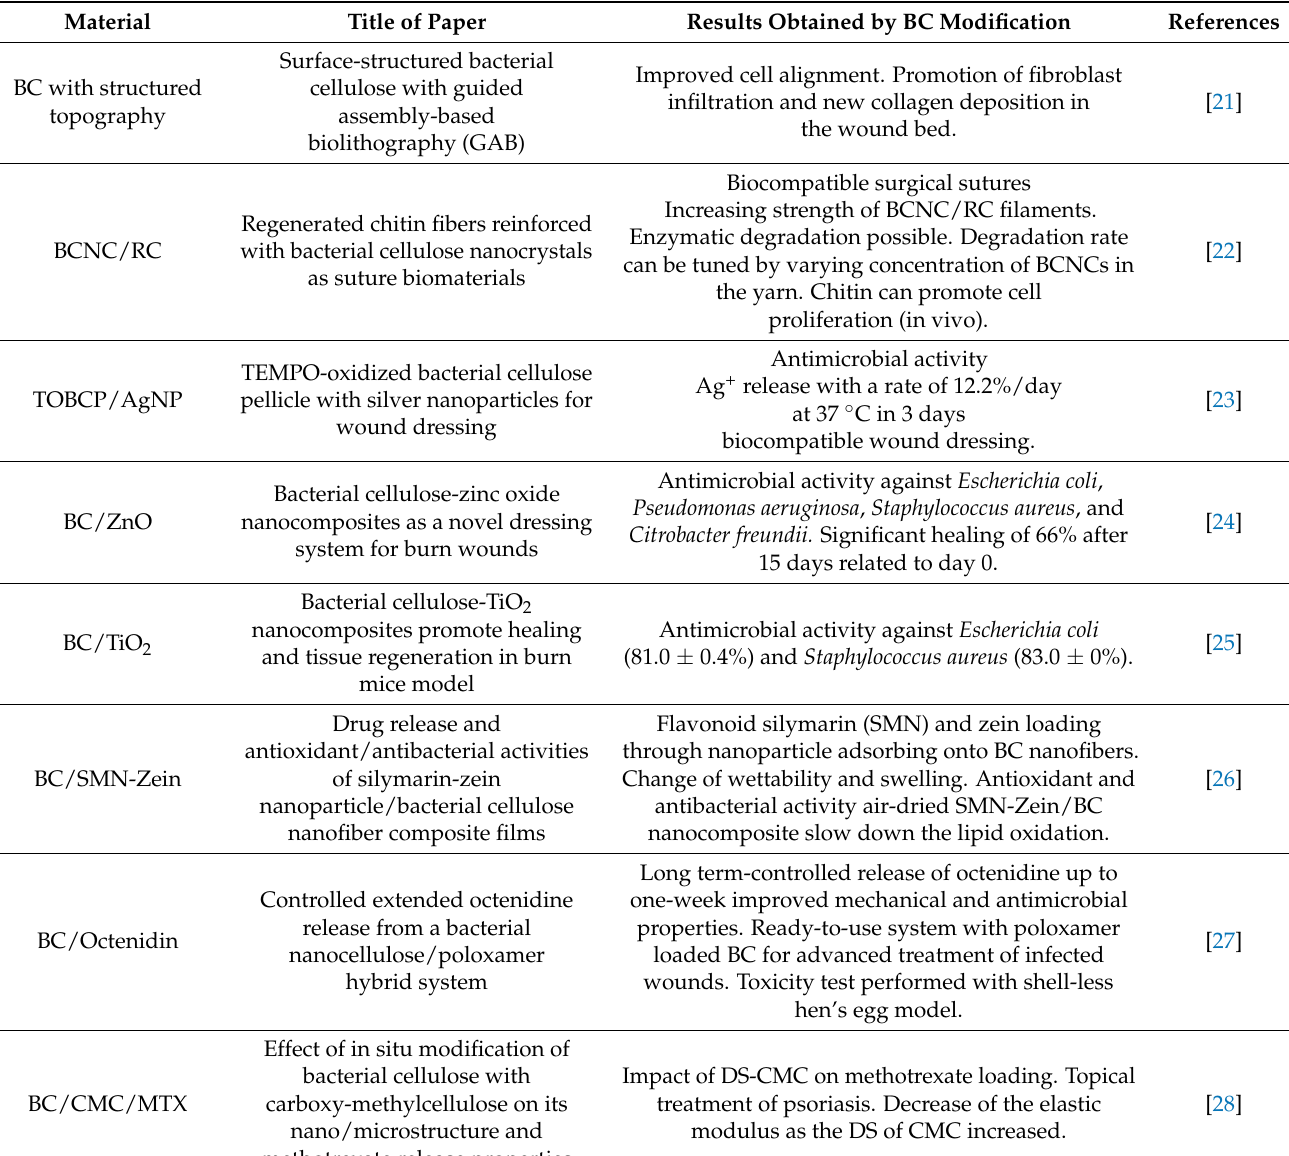
Table 1. Modifications of bacterial cellulose (BC) and properties resulting from the modifications